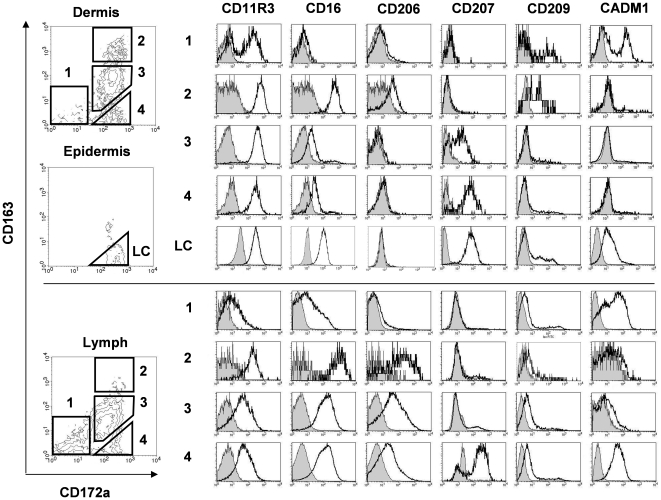
Characterization of the 4 DC subsets present in skin and lymph.FACS analysis of DC from dermis, epidermis and pseudo-afferent iliac lymph. DC were gated using the same criterions as in Figure 1 (FSChigh/MHC-IIhigh). The expressions of the markers identified in Figure 1 were differentially reexamined on lymph and dermal DC subpopulations characterized as CD163neg/CD172aneg (1), CD163high/CD172apos (2), CD163low/CD172apos (3), and CD163neg/CD172apos (4). In epidermis, Langerhans cells (LC) were retrieved in the same gate than population (4) from dermis and lymph. Histograms depict isotype control (plain histograms) versus indicated marker expression (bold, open histograms) and are representative of at least 3 independent experiments on 3 different animals.